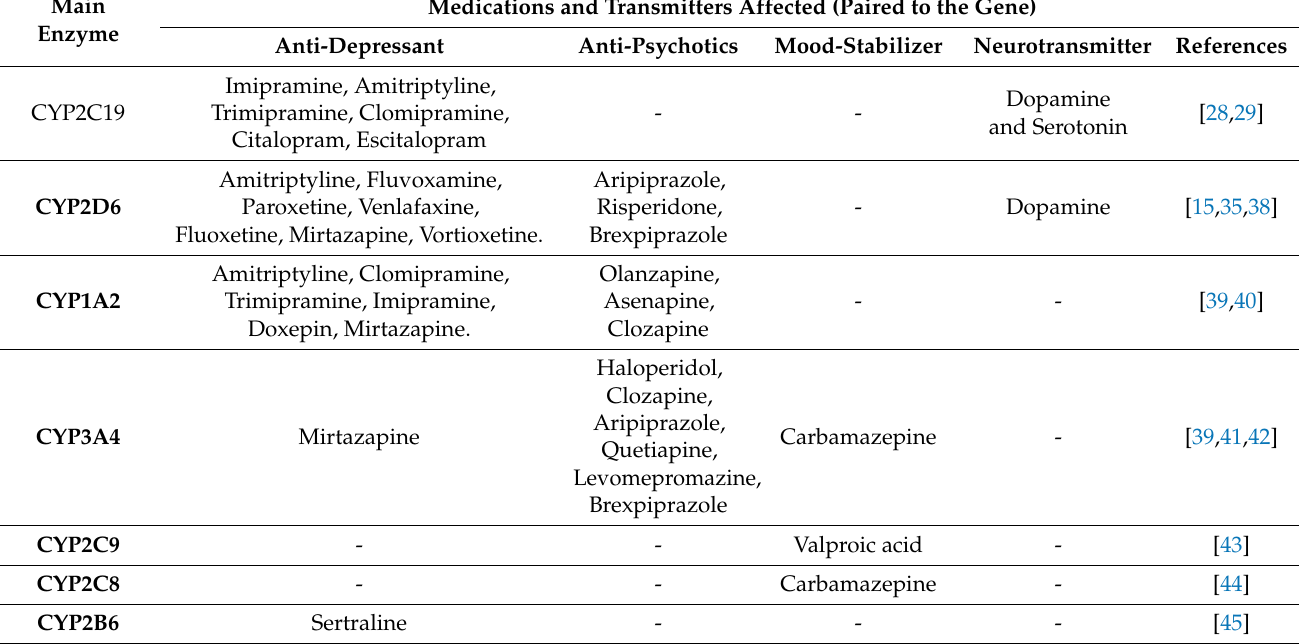
Table 2. Summary of the main metabolizing Cyp450 isoenzyme of psychotropic agents and endoge- nous